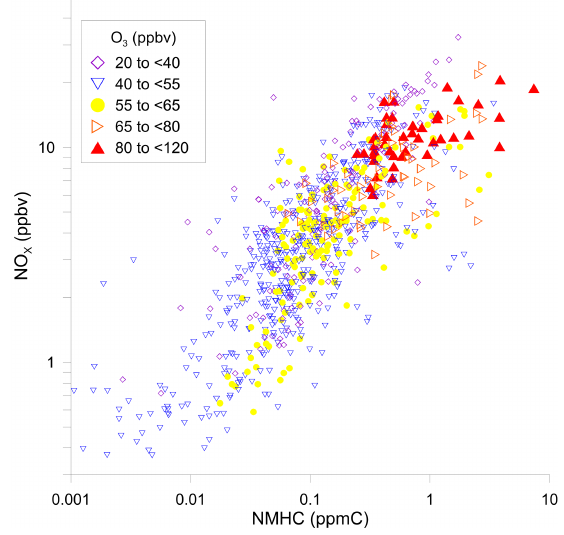
Figure 4. O 3 , NMHC and NO x during daytime (11:00 to 20:00) for the period January to March 2011 at Boulder South Road